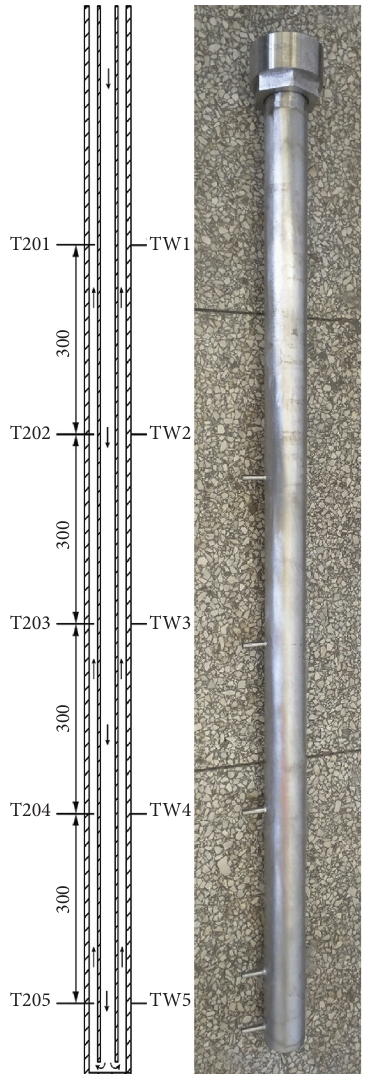
Figure 2: Temperature measurements of the condensing